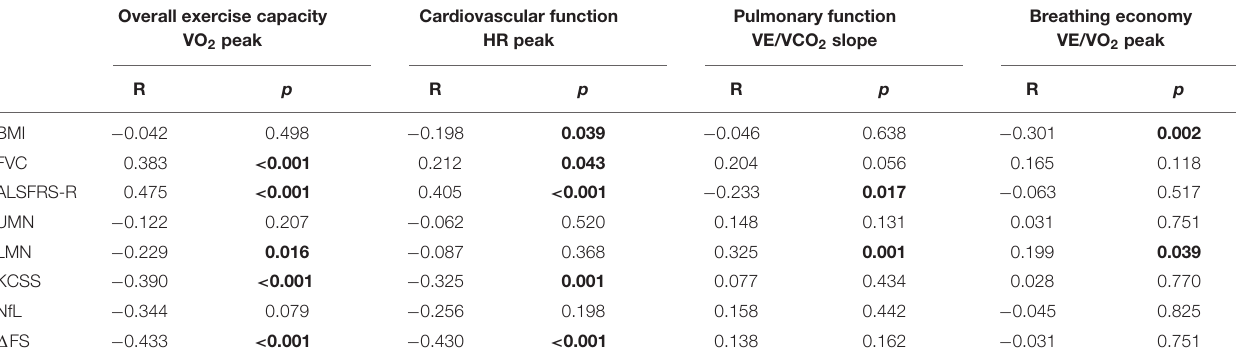
FIGURE 3 | Changes in typical CPET variables relative to disease severity and disease progression in ALS. (A) Changes in the CPET relative to disease severity as graded by the KCSS. (B) Changes in the CPET relative to disease progression scored by the (cid:49) FS. Typical CPET changes included (a) overall exercise capacity, represented by the VO 2 peak, (b) cardiovascular function, represented by HR peak, (c) pulmonary function, represented by VE/VCO 2 slope, and (d) breathing economy, represented by the VE/VO 2 peak. The p -value is based on the Kruskal-Wallis test and Spearman’s correlation. Vertical lines indicate medians (IQR). ALS, amyotrophic lateral sclerosis; CPET, cardiopulmonary exercise testing; (cid:49) FS, (48-[ALSFRS-R])/disease duration from symptom onset to the CPET assessment; ALSFRS-R, ALS Functional Rating Scale-Revised; KCSS, King’s College Staging System; VO 2 , oxygen consumption; HR, heart rate; VE, minute ventilation; VCO 2 , carbon dioxide production; IQR, interquartile range. ** p < 0.01. TABLE 3 | Correlations of CPET variables with disease characteristics of